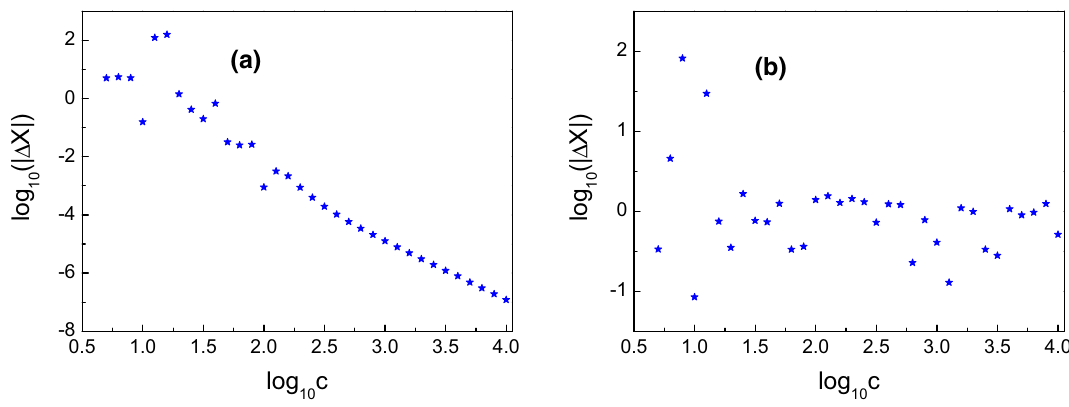
Fig. 5 Dependence of orbital errors | Δ X | on c between orbits in the truncated system (16)–(17) and those in the exact system (12) with the same initial values: a Orbit 1; b Orbit 3